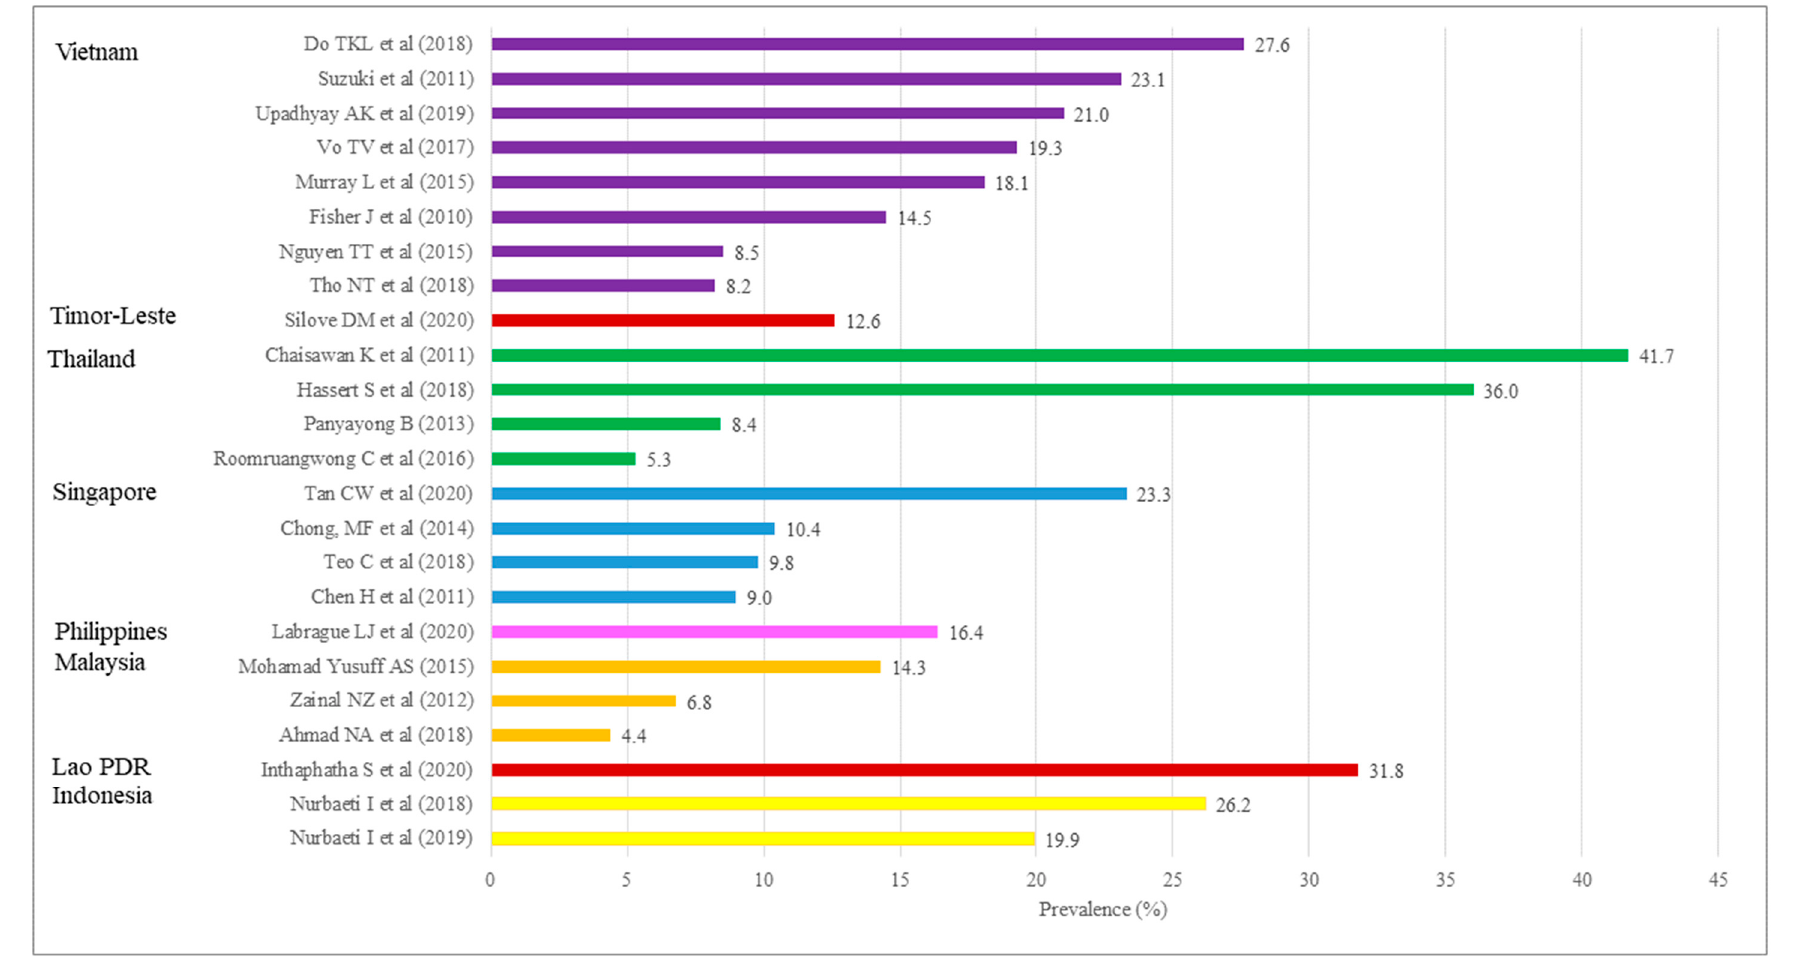
Figure 3. Prevalence of postpartum depression in the ASEAN member countries [34–57].